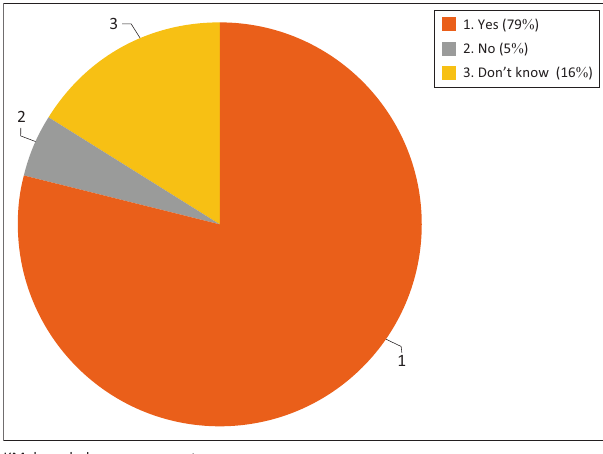
FIGURE 4: Implementing a knowledge management initiative at KwaZulu-Natal Department of Public Works to enhance performance and service delivery ( N = 61).